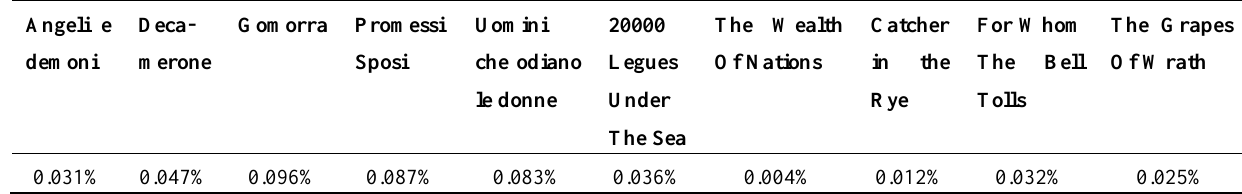
Table 2. Compression